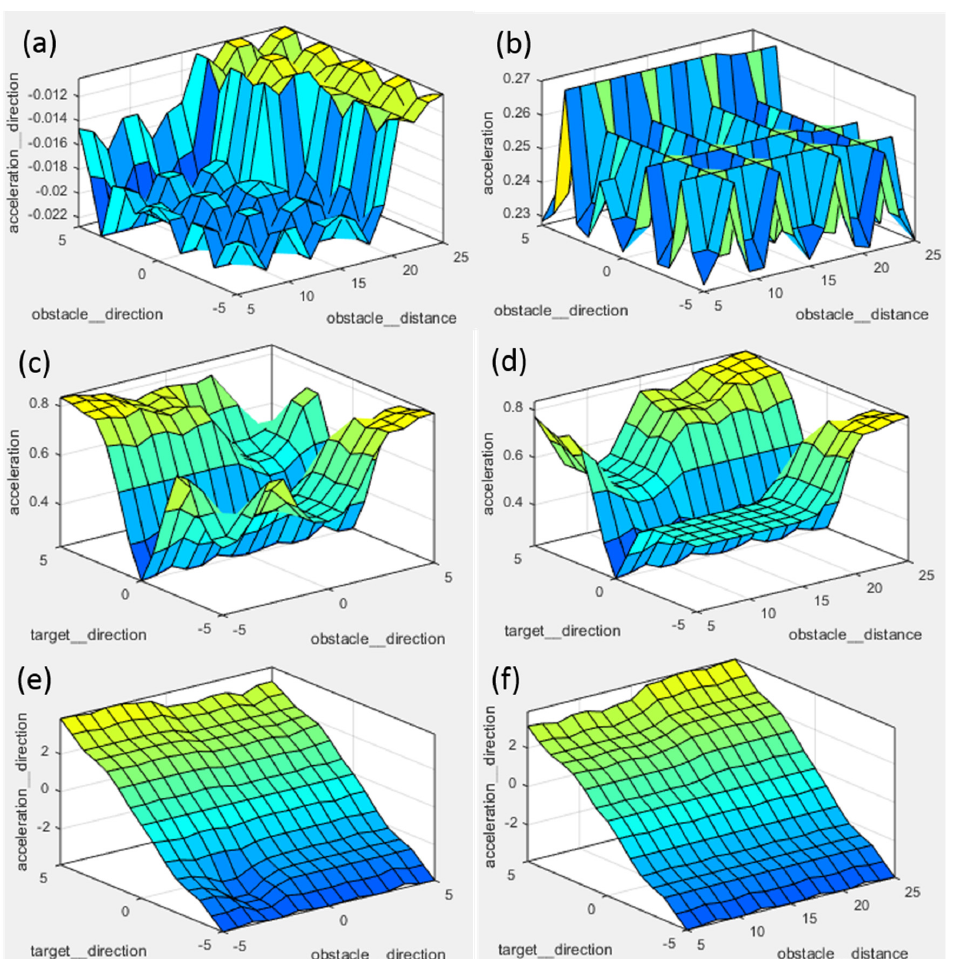
Figure 10. 3D graphs for inputs and outputs. ( a ) obstacle direction, obstacle distance versus acceleration direction; ( b ) obstacle direction, obstacle distance versus acceleration; ( c ) target direction, obstacle direction versus acceleration; ( d ) target direction, obstacle distance versus acceleration; ( e ) target direction, obstacle direction versus acceleration direction; and ( f ) target direction, obstacle distance versus acceleration direction.